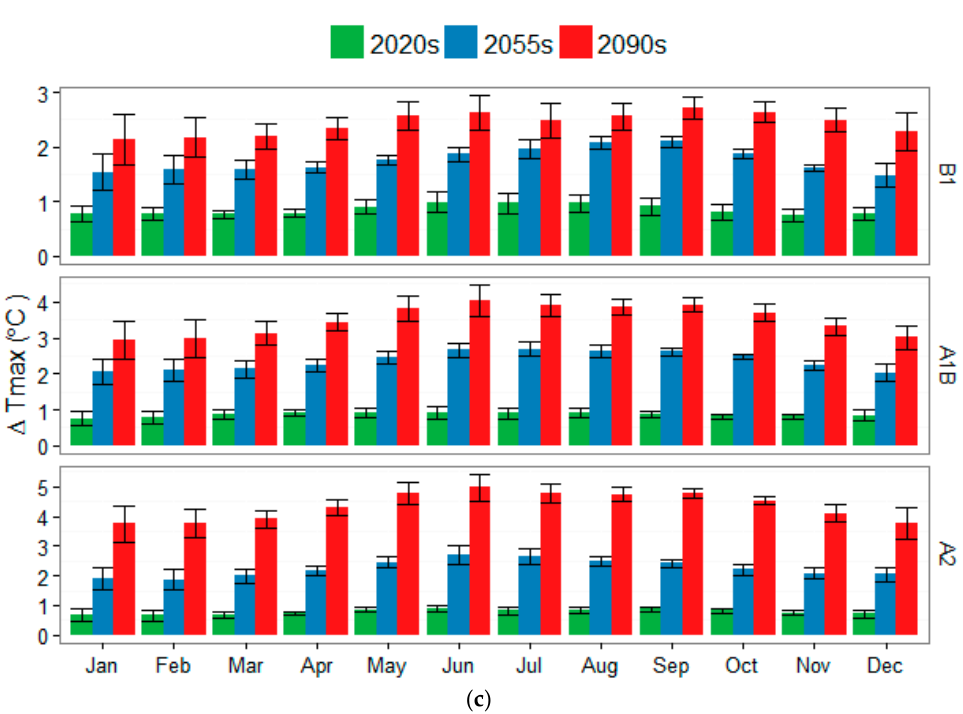
Figure 4. Changes in GCMs’ predicted monthly climate variables compared with the baseline under three emissions scenarios (A2, B1, A1B) and for three future periods (2020s, 2055s, and 2090s): monthly total precipitation ( a ); monthly average Tmin ( b ); and monthly average Tmax ( c ). Results are based on averages from 15 GCMs.